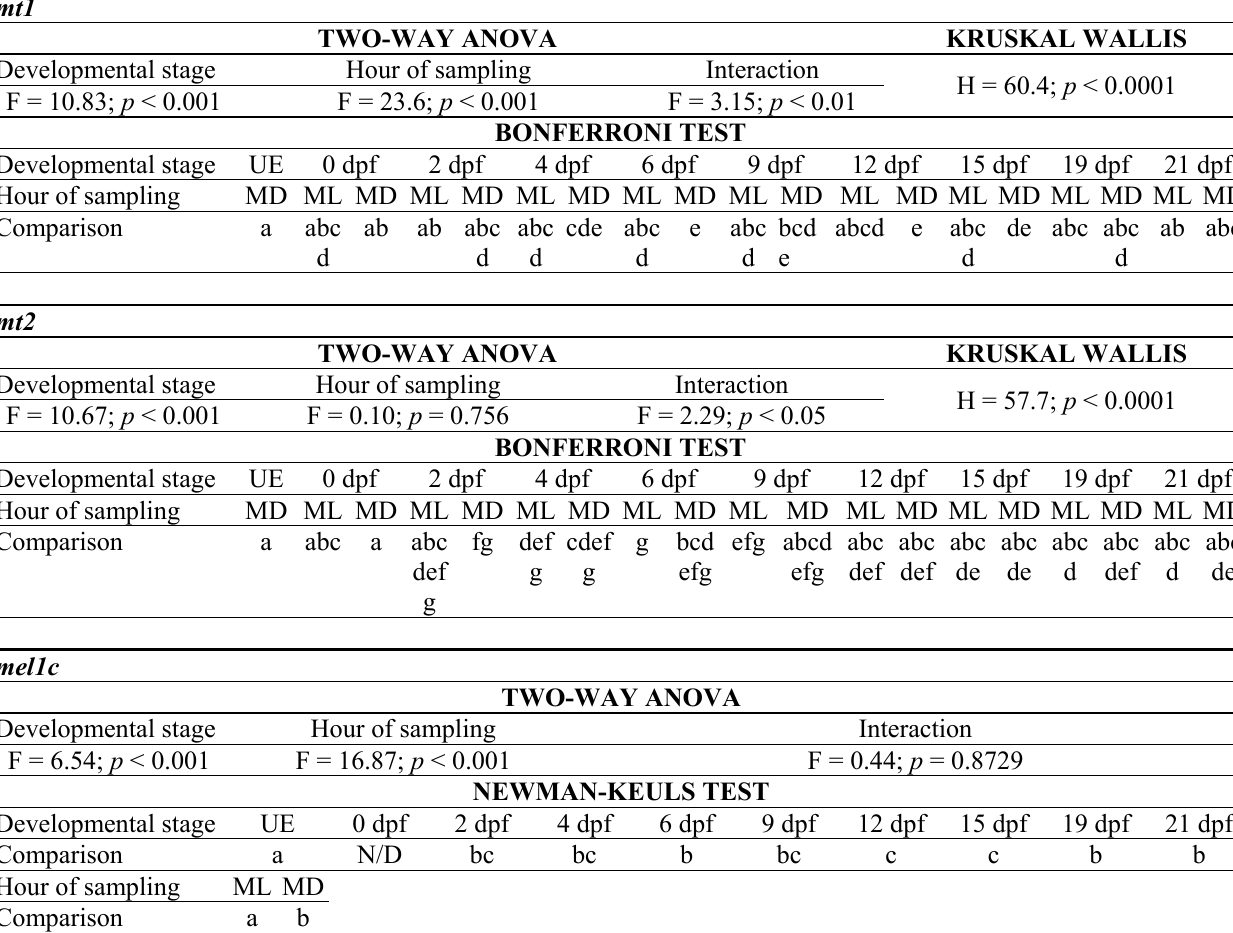
Table 1. Significance levels of statistical analysis for each melatonin